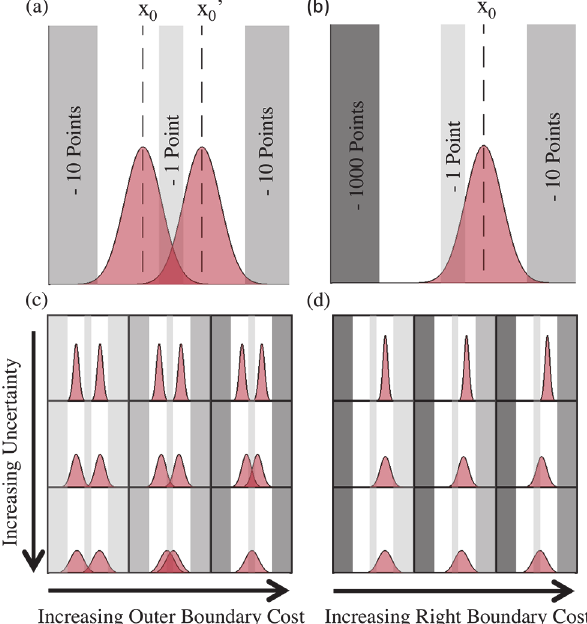
Fig 1. Theoretical minimization of cost under uncertainty. In Fig 1 (a)-(d), the shaded red distributions represent an uncertainty or variability in position. Grey bars signify penalty regions, the darker the grey, the higher the cost. The peaks of the curves illustrate the optimal position to minimize cost based on the standard deviation of uncertainty and the cost function. In (a) the loss function is symmetrical. The result is that there are two optimal positions that will minimize cost. Fig 1 (c) demonstrates the effect of increasing the cost of the outer boundary, dark grey regions, from left to right (1, 10, 100). The result is a shift in peaks toward the lower cost region in the center. Similarly, as the standard deviation of uncertainty increases from top to bottom (.35,. 75, 1) the optimal position again shifts toward the center lower cost region. At high standard deviation of uncertainty and high outer boundary cost, the optimal position becomes directly in the center of the middle region. Fig 1 (b) and (d) illustrate the same phenomenon for an asymmetrical loss function. Here the left boundary penalty remains very high (1000 points) while the right boundary in (d) increases from left to right (1, 10, 100). In this case there are no longer two optimal positions, only one in the segment that is farther away from the high cost.